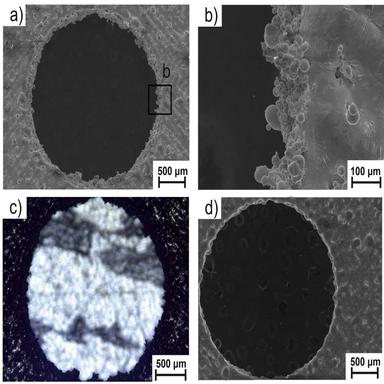
(a) SEM image of Circle 1 in the as-built condition. (b) Powder particles sintered to the melted part (region b in (a) with higher magnification). (c) OM image of Circle 1 in the asbuilt condition, and (d) SEM image of Circle 1 with powder particles removed via sandblasting.